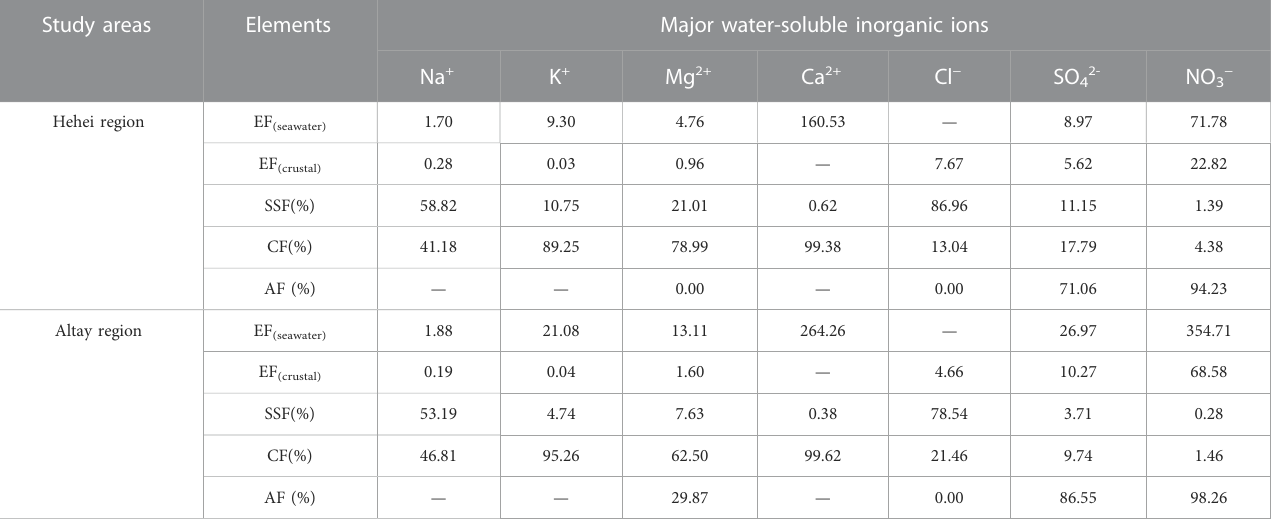
TABLE 4 Main inorganic ion EF values and the contribution of ion sources in the study area. Study